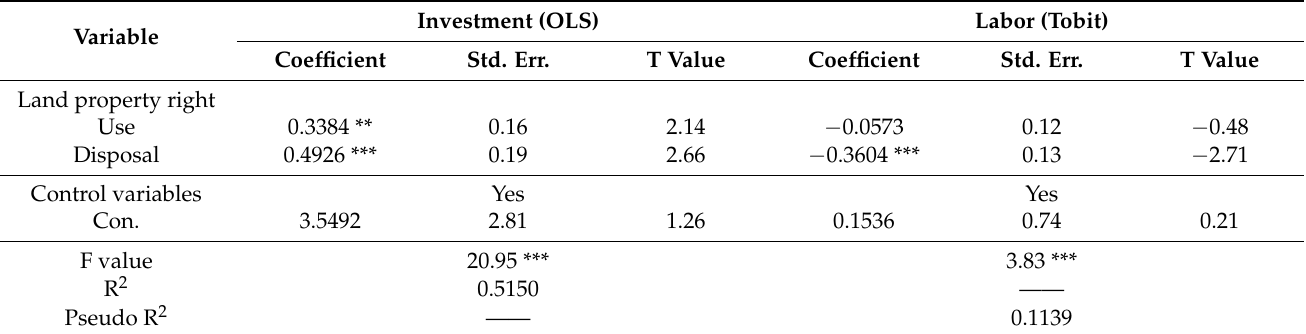
Table 4. Estimate results of land property rights on intermediary